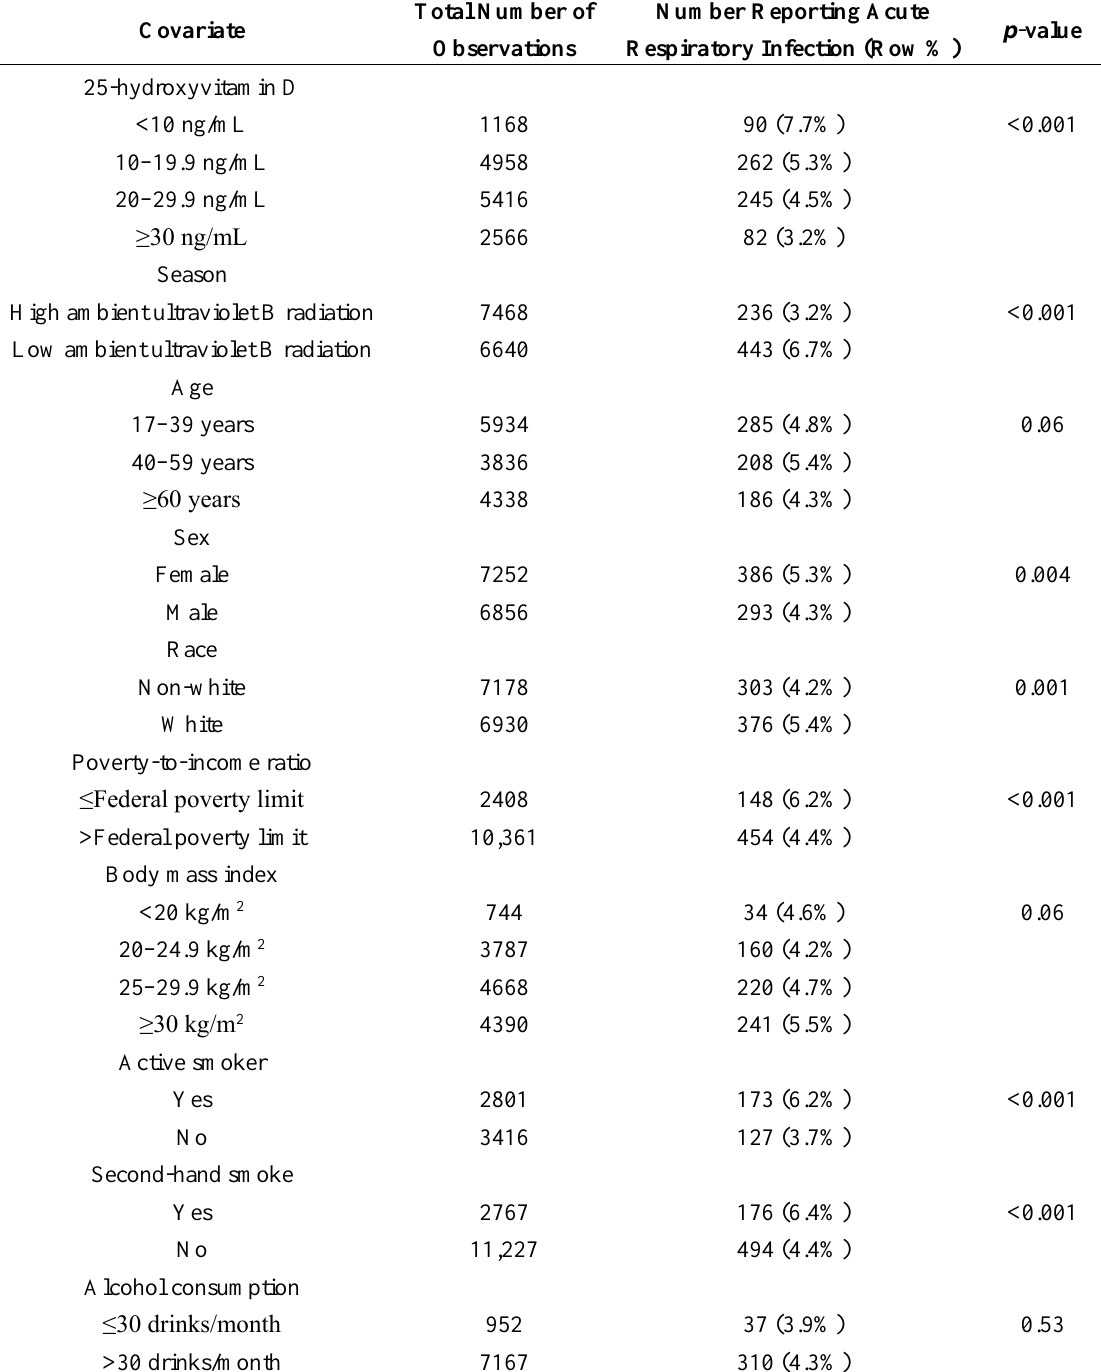
Table 1. Overall sample characteristics and sub-groups with acute respiratory